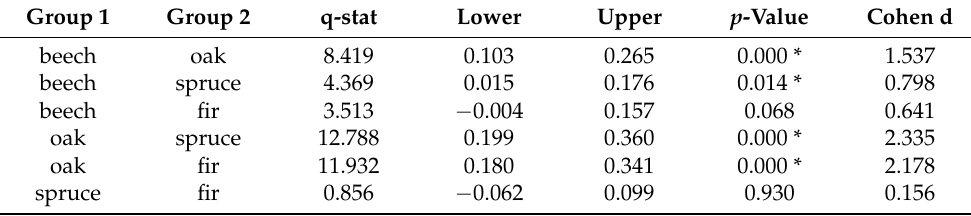
Table 3. Results of Tukey’s HSD post hoc analysis of respirable mass concentration data.